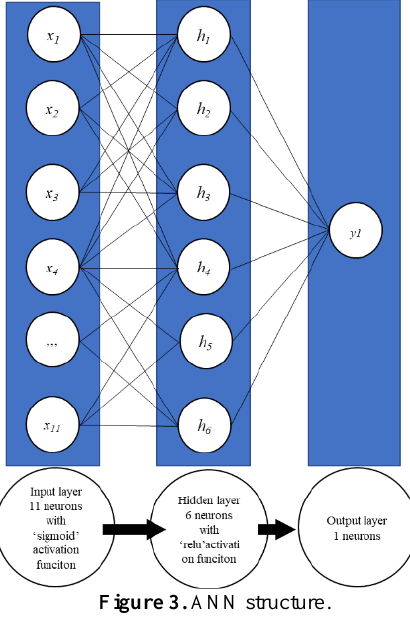
Figure 3. ANN structure.